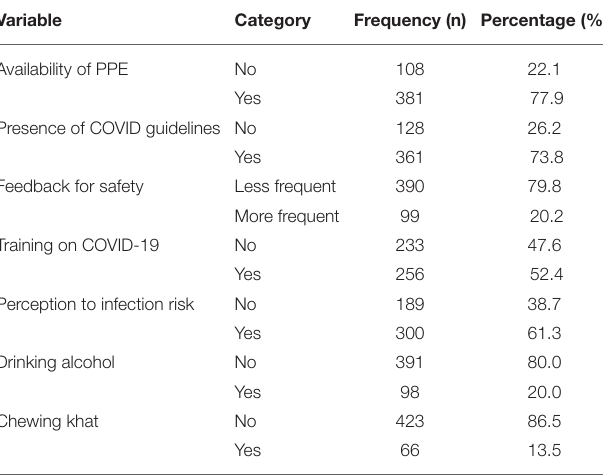
TABLE 1 | Socio-demographic characteristics of healthcare workers in public hospitals of South Wollo Zone, Northeastern Ethiopia, 2021.